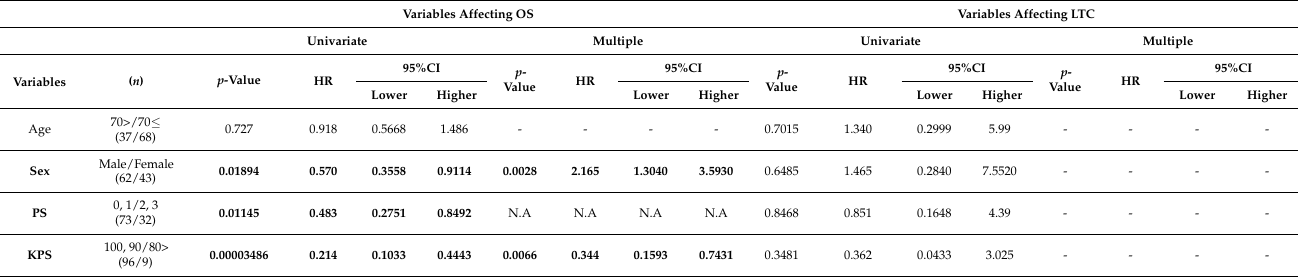
Table 4. Univariate and multivariate analyses of clinical and treatment factors potentially associated with overall survival and local tumor